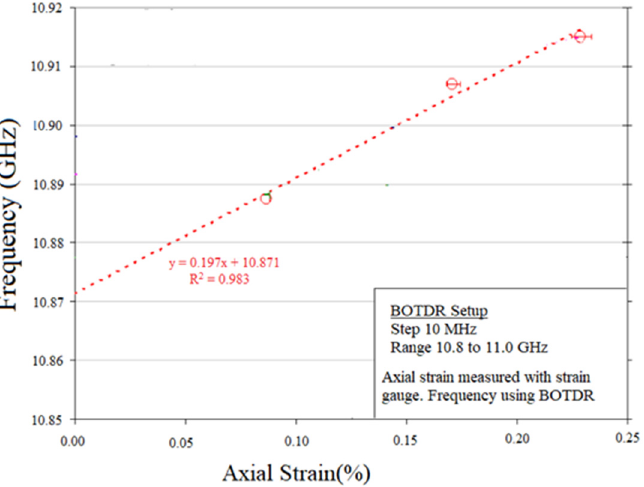
Figure 8. Correlation between average frequencies and strains measured by strain gauge [21].